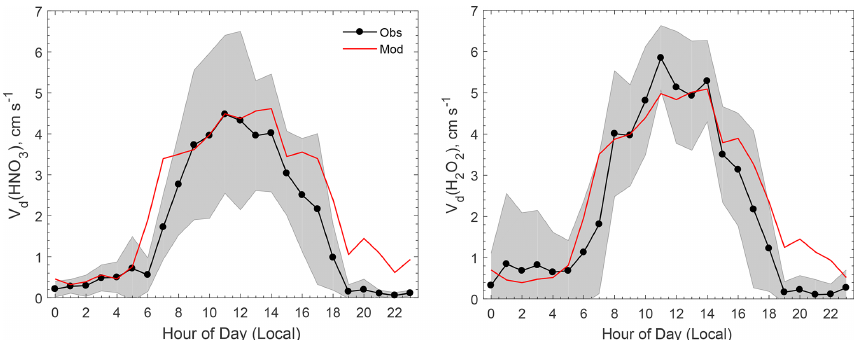
Figure 1. Comparison of the observed and modeled average diel variations of dry deposition velocities ( V d ) for HNO 3 and H 2 O 2 . The shaded area indicates the standard deviation of the observations. The model assumes that surface resistances ( R c ) for HNO 3 and H 2 O 2 are zero.